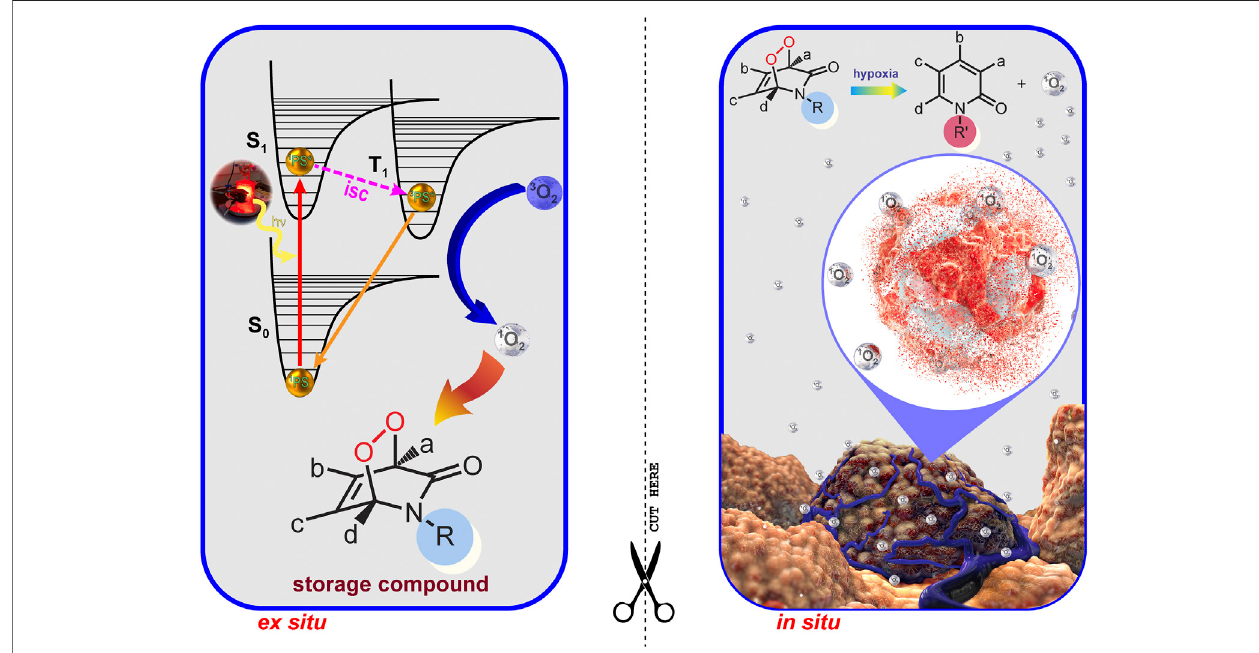
FIGURE 7 | Two Stage PDT. Two stage PDT can overcome the issues of light attenuation and oxygen de fi ciency in tumors. Reproduced from (Ayan et al., 2020) (published by The Royal Society of Chemistry) with permission from the Royal Society of Chemistry.